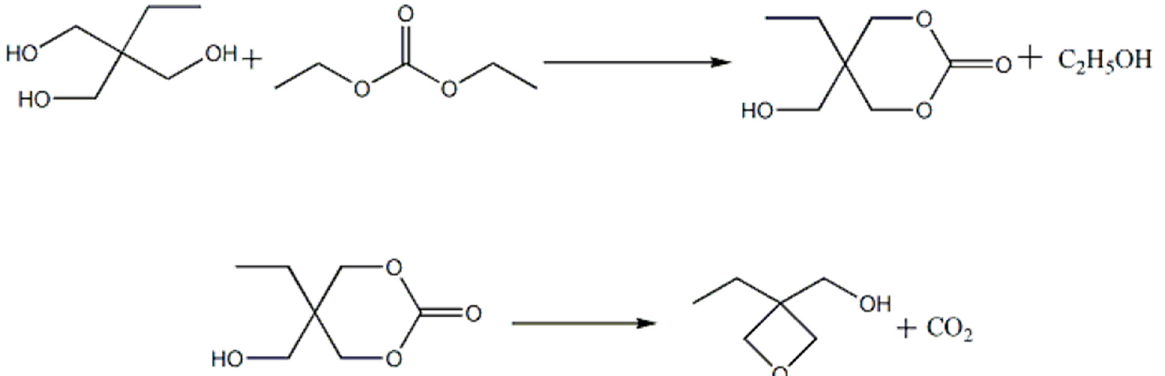
Figure 1. The synthetic route of 3-ethyl-3-hydroxymethyloxetane.